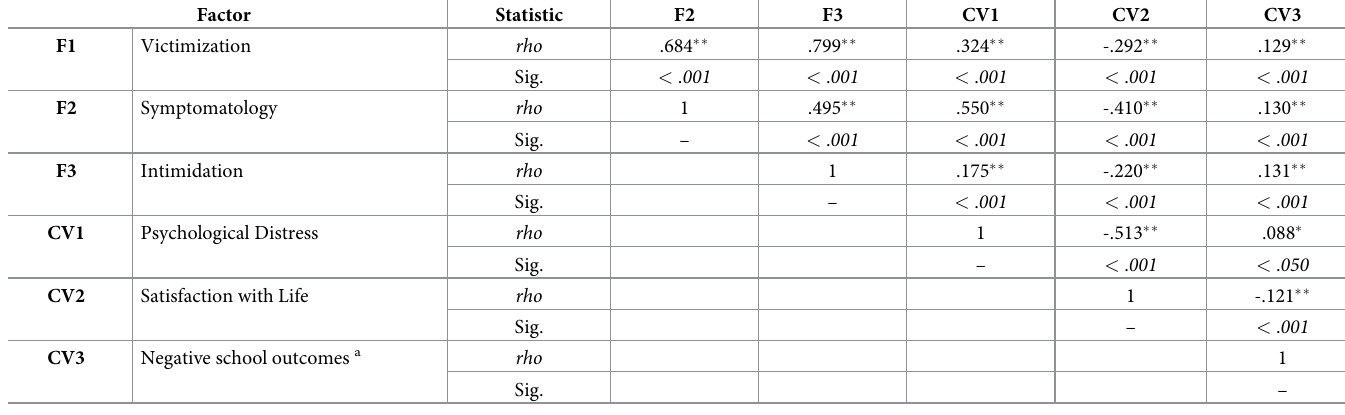
Table 4. Concurrent validity (bivariate correlations) between CIE-A factors and theoretically related Criterion Variables (CVs).